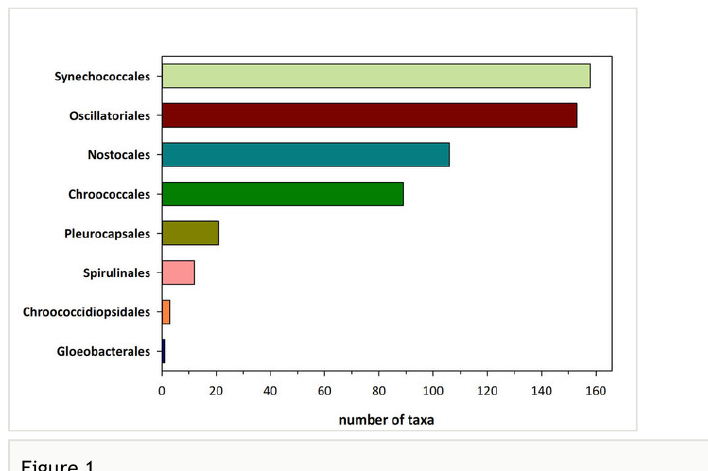
Figure 1. Classi fi cation of cyanobacteria of Greece in orders.